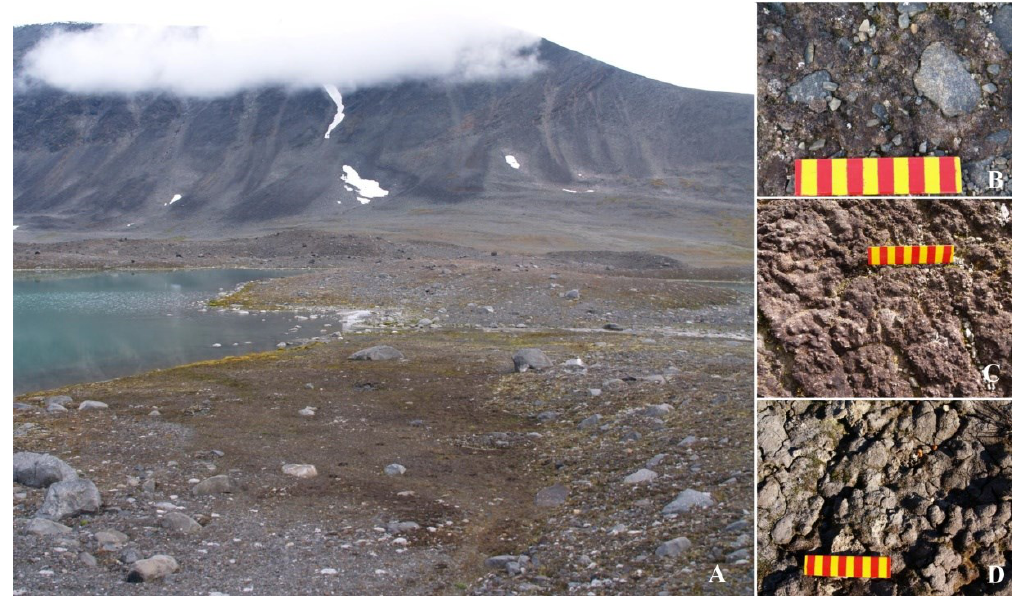
Figure 1. Tarfala Valley landscape ( A ); magnification of sites where C02 ( B ); C10 ( C ) and C12 ( D ) samples were collected. Scale: yellow/red bands 1 cm.